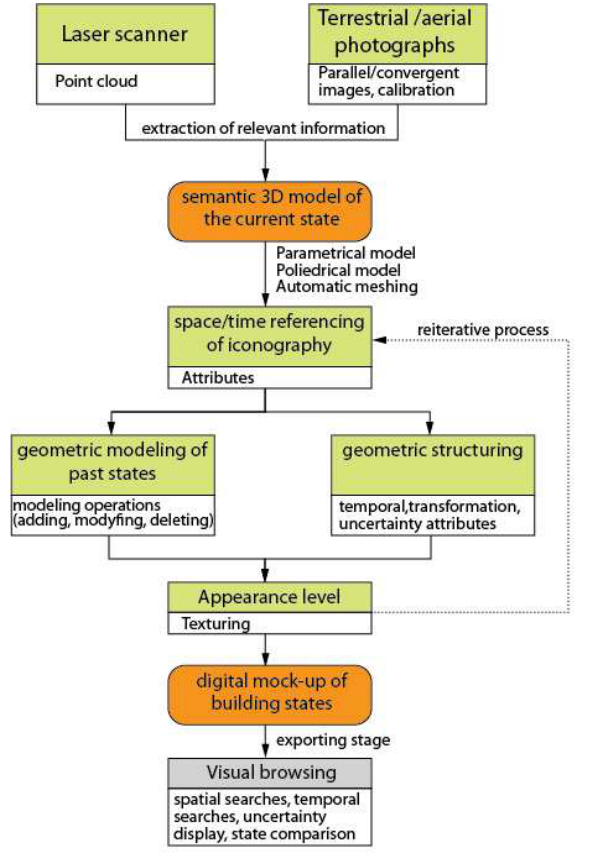
Figure 1. Pipeline for the iconography-based approach The presented functions are included in the NUBES platform, developed at the MAP Laboratory. In particular, the modelling process is achieve with NUBES Forma, a 3D reconstruction tool based on point clouds and photogrammetry, developed as a Maya Plug-in in MEL (Maya Embedded Language) and C++. It is displayed in NUBES Visum, a 3D Web Information System at the architectural scale, developed in PHP/MySQL and Virtools DEV.